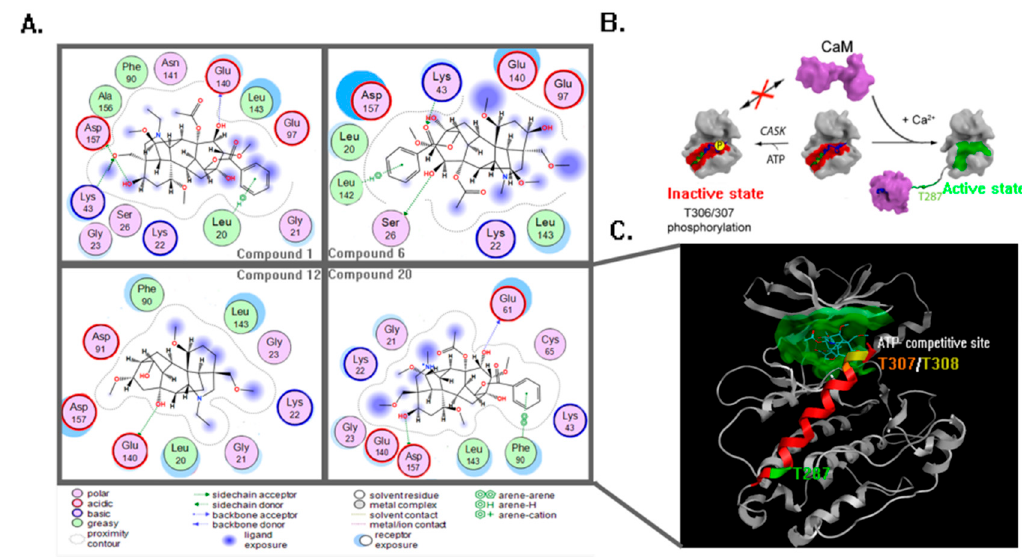
Figure 8. ( A ) The interactions between the four compounds and amino acids are shown by the ligand interaction function in MOE software. ( B ) The mechanisms of the CaMKII activation state and inactivation state. ( C ) The dock result of Compound 20 . Compound 20 docked into 2V7O, and the ATP-competitive pocket was painted green; the T287, T307, and T308 phosphorylation sites were painted green, orange, and yellow, respectively; the inhibitory helix was painted red.